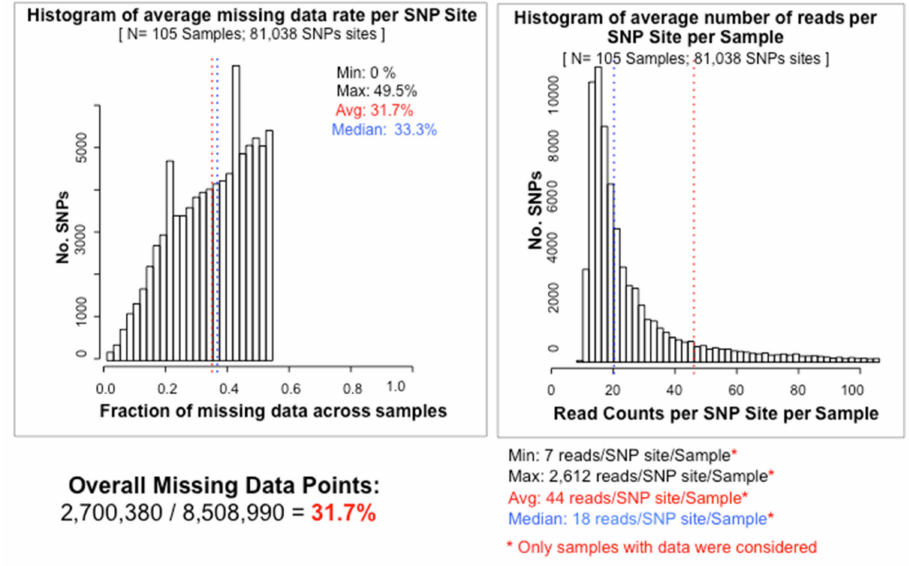
Figure 3. LMD50 SNPs average missing rate per SNP and read counts per SNP site per sample. The average missing data rate per LMD50 SNP site across samples is provided in the left panel and minimum, maximum, average and median number of reads per SNP per sample are shown in the right